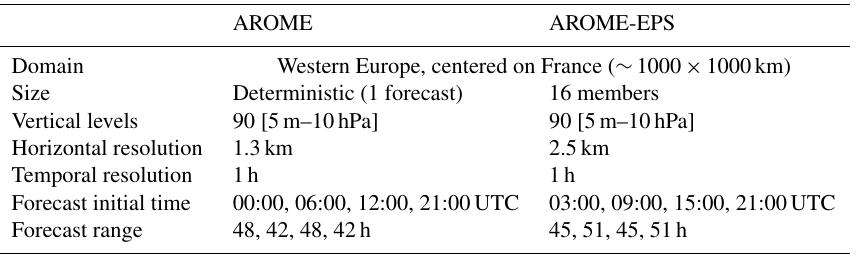
Table 2. Description of AROME and